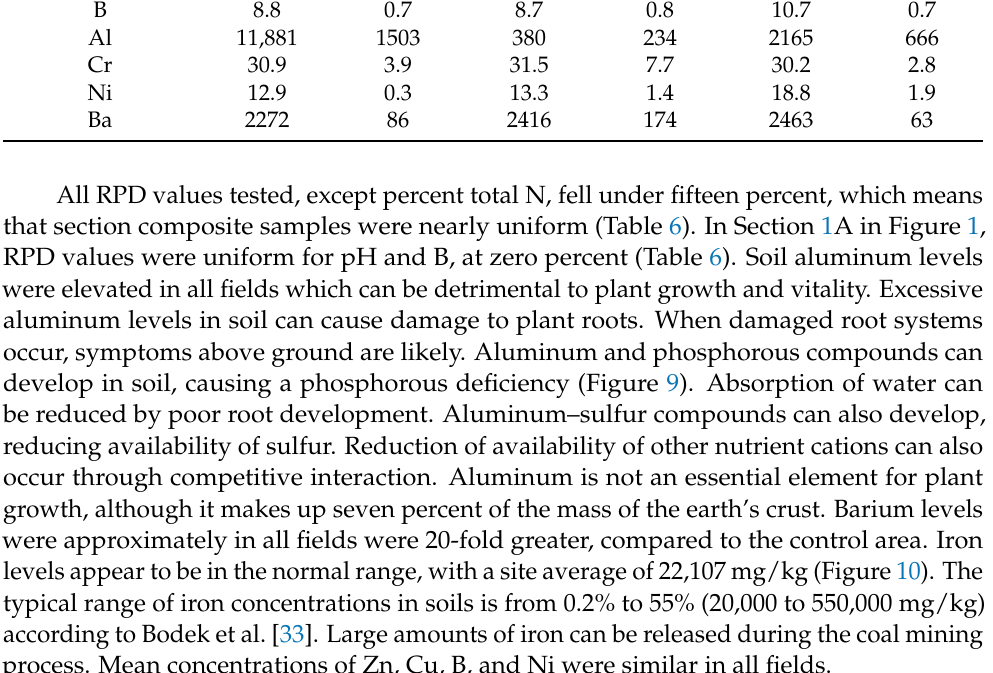
Table 5. Total elemental levels (mg/kg) of three fields at the study site analyzed by EPA digestion Method 3050B. Mean of six composite soil samples collected in each field (SD: standard deviation). Field 1 Field 2 Field 3 Parameters Mean SD Mean SD Mean SD S 588 52 646 71 894 57 Na 165 1823 Fe Mn 331 Zn 35.7